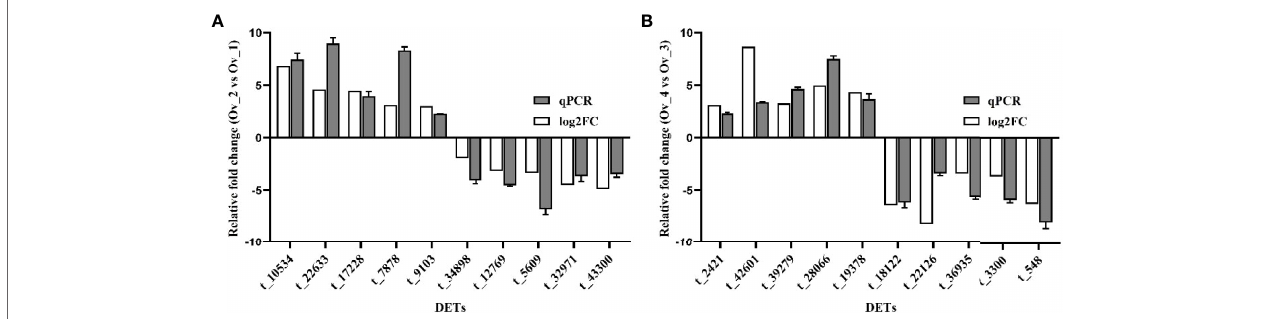
FIGURE 6 | Validation of the expression levels of five upregulated and five downregulated DEGs in Stage II vs Stage I (A) and Stage IV vs Stage III (B) RNA-Seq and qRT-PCR data are indicated in grey and white, respectively t_10534, CYP307; t_22633, Adenylyl cyclase-associated protein; t_17228, checkpoint kinase 1; t_7878, glutathione S-transferase; t_9103, adiponectin receptor; t_34898, serine/threonine-protein kinase Doa; t_12769, cyclophilin A; t_5609, lipoprotein receptor 2A; t_32971, guanylate cyclase PcGC-M2 precursor; t_43300, ficolin-like protein 2; t_2421, aurora kinase B; t_42601, calcified cuticle protein; t_39279, cyclin-dependent kinases 2; t_28066, forkhead box L2; t_19378, Serine/threonine-protein kinase D3; t_18122, alkaline phosphatase; t_22126, growth/differentiation factor 8; t_36935, cathepsin L; t_3300, cyclin-dependent kinase inhibitor; t_548, fatty acid